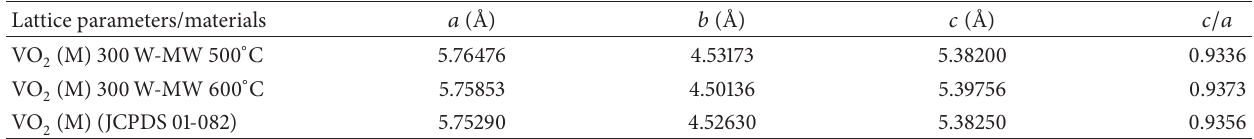
(M) analyzed by 2